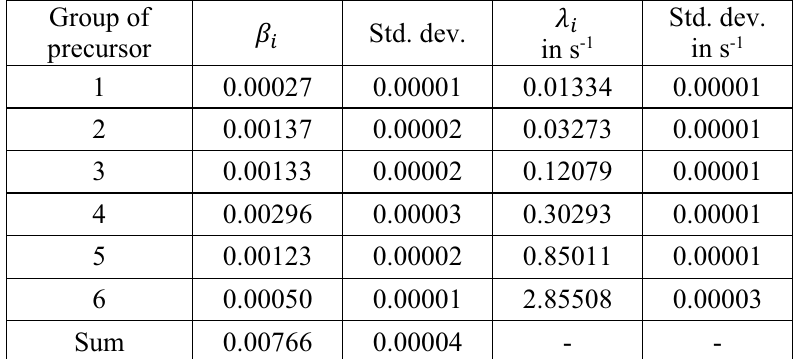
Table I. Simulated precursor parameters: